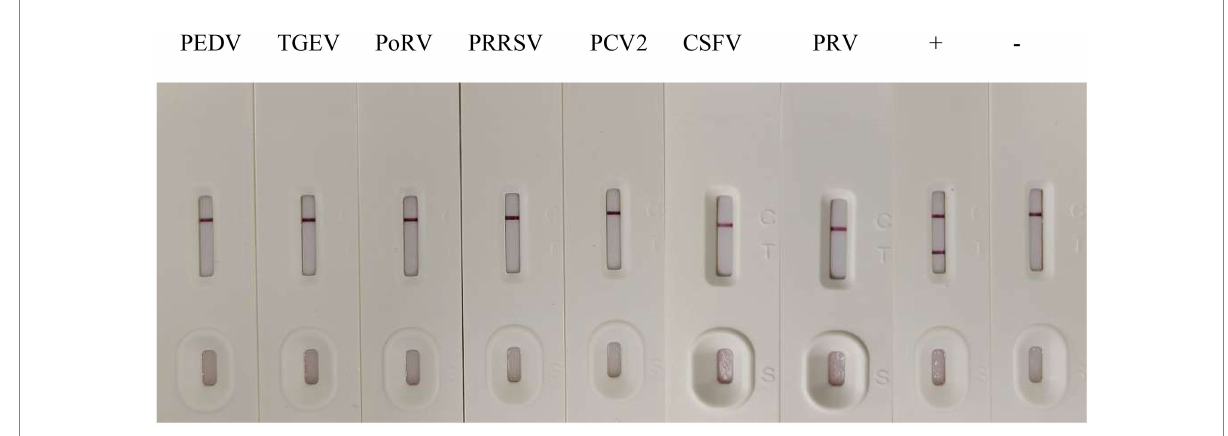
FIGURE 6 Specificity of the GICA strip. PDCoV cell culture supernatant as a positive control (+), LLC-PK1 cells as negative control ( − ), PEDV, TGEV, PoRV, PRRSV, PCV2, CSFV and PRV were tested with the strip.